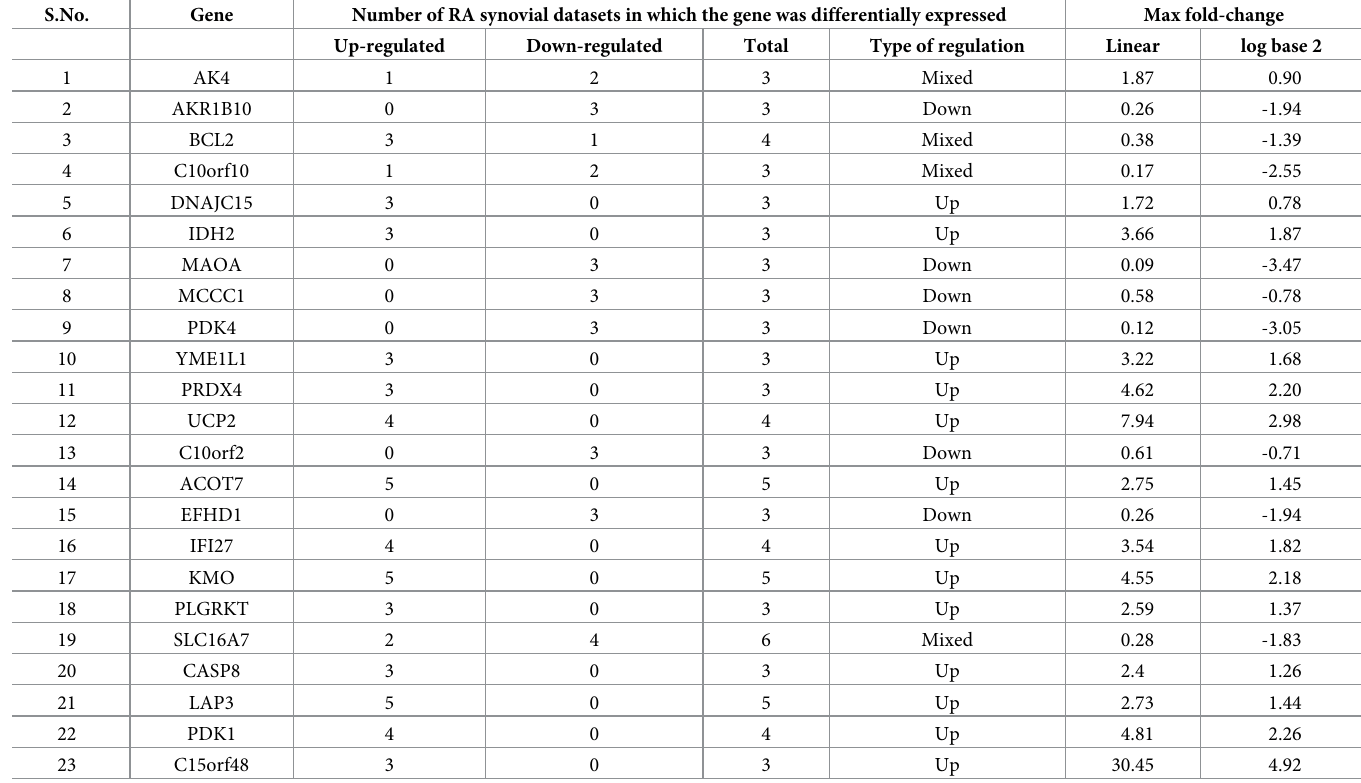
Table 2. The differentially expressed genes (DEGs) of mitochondrial proteins in at least three synovial microarray datasets. S.No. Gene Number of RA synovial datasets in which the gene was differentially expressed Max fold-change Up-regulated Down-regulated